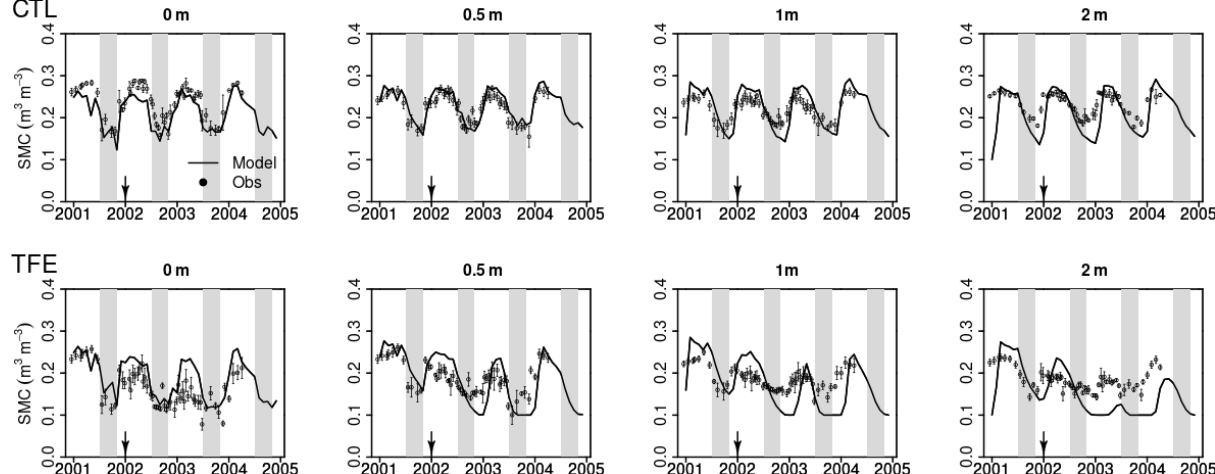
Figure 4. Modeled (ORCHIDEE-CAN-NHA, black line) vs. observed (black dots) volumetric soil moisture content (SMC) at different depths. Due to the limited time duration of observation data, we only show the modeled SMC during 2001–2004. The shaded gray vertical area indicates the dry seasons from July to November.